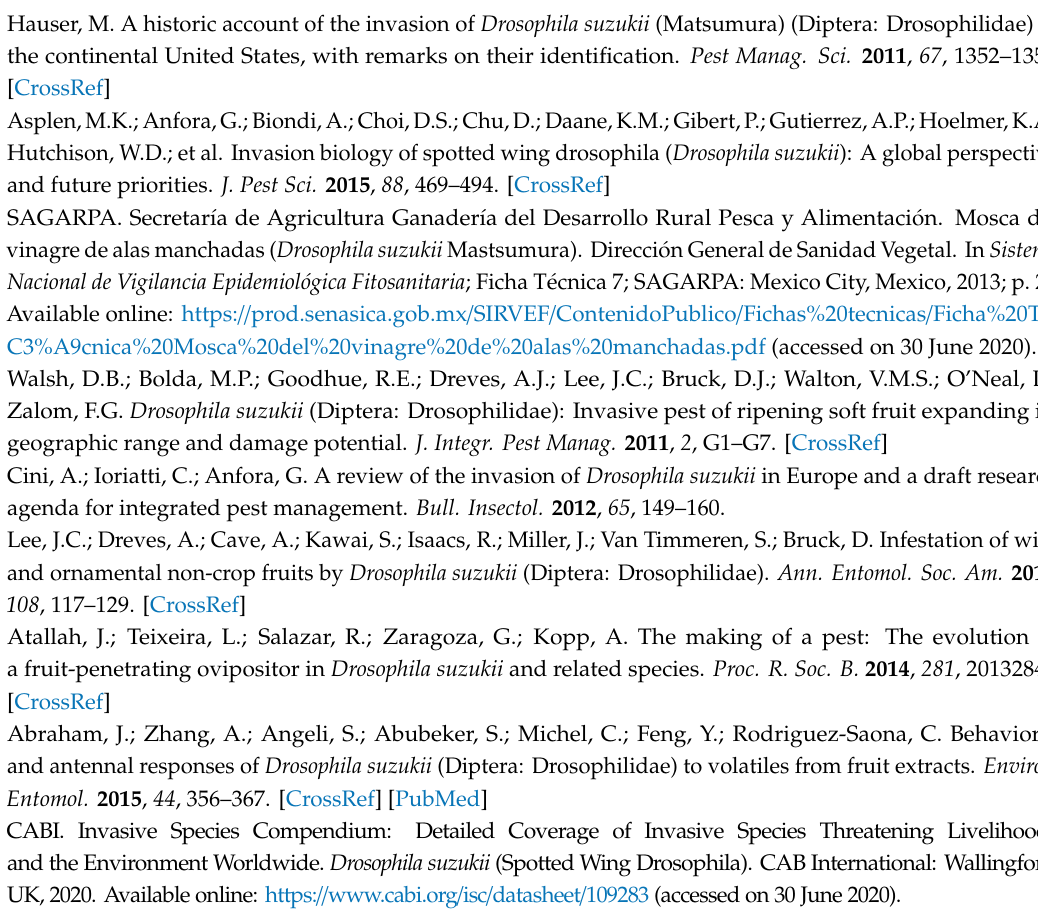
Table S1: Characteristics of di ff erent brands of vinegars used in the